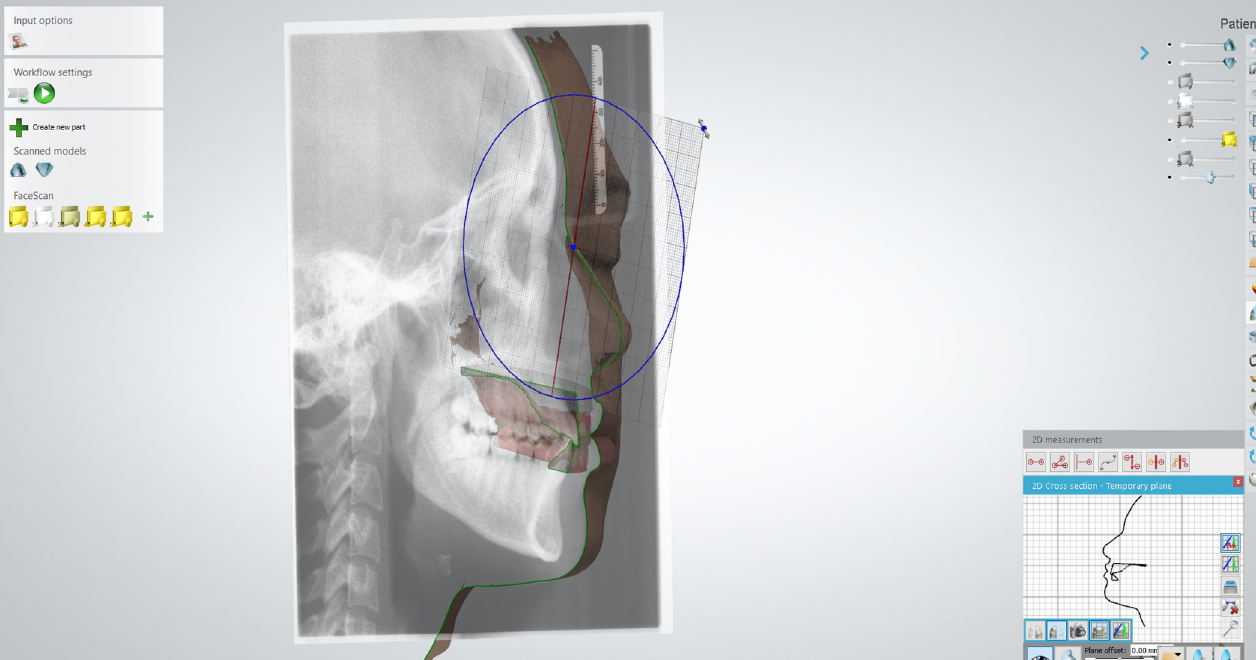
Figure 9. L ateral cephalogram is superimposed to the face scan. Figure 9. Lateral cephalogram is superimposed to the face